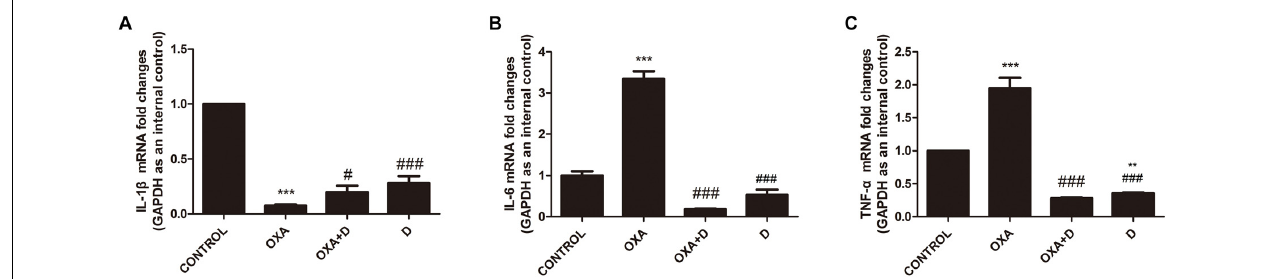
FIGURE 10 | Transcript levels of the proinflammatory cytokines IL-1 β , IL-6 and TNF- α in the mouse DRG. Total mRNA was extracted from mouse DRG tissues. qPCR was performed and a comparison is shown between different groups after saline or 28 days of drug treatment. (A) IL-1 β expression was significantly decreased after OXA treatment, but duloxetine did not affect this decrease. (B) Duloxetine significantly decreased the expression of IL-6 mRNA in the DRG of OXA-treated mice. (C) Duloxetine significantly decreased the expression of TNF- α mRNA in the DRG of OXA-treated mice. ( ∗∗ p < 0.01, ∗∗∗ p < 0.001 vs. control; # p < 0.05 vs. OXA, ### p < 0.001 vs. OXA). The data are presented as the means ± SEM ( n = 5).